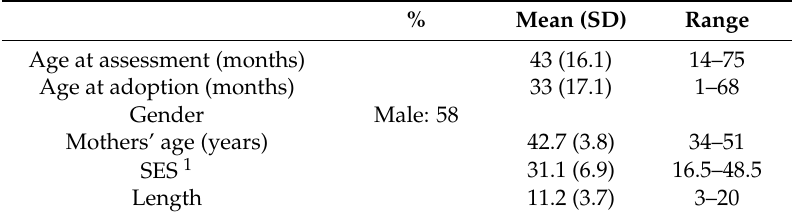
Table 1. Demographic characteristics of adopted children and